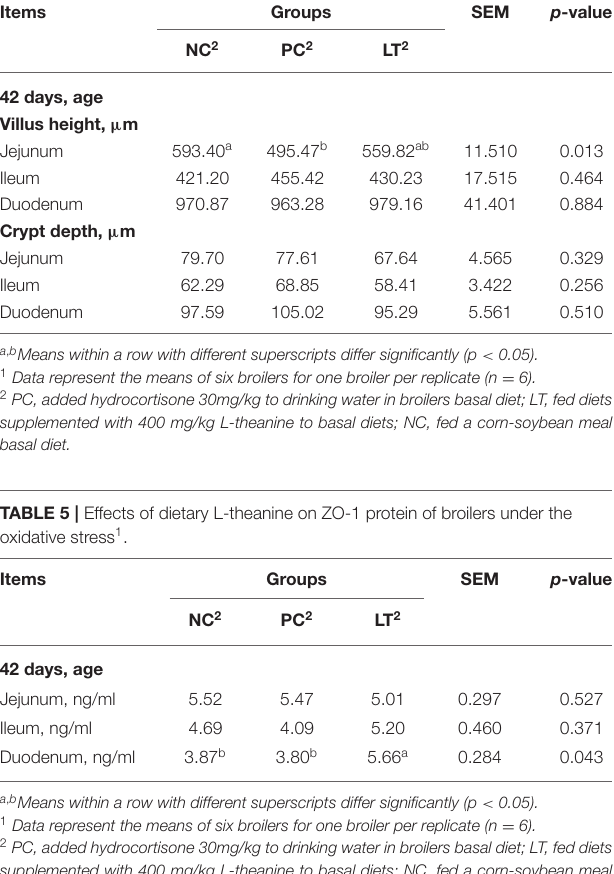
TABLE 4 | Effects of dietary L-theanine on intestinal morphology of broilers under the oxidative stress 1 . Items